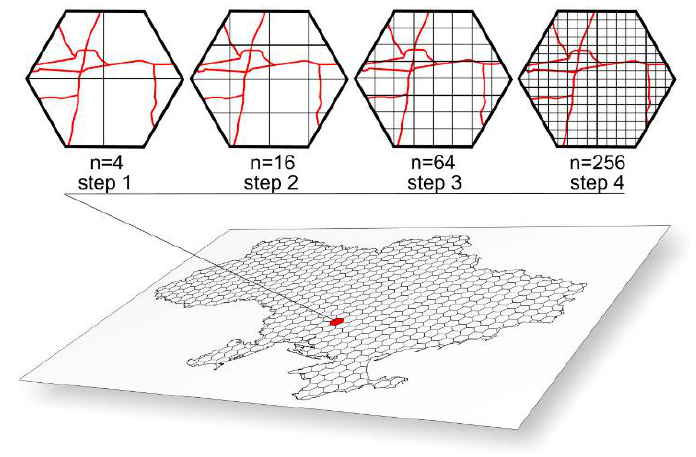
Figure 5. Steps for executing the box-counting method.